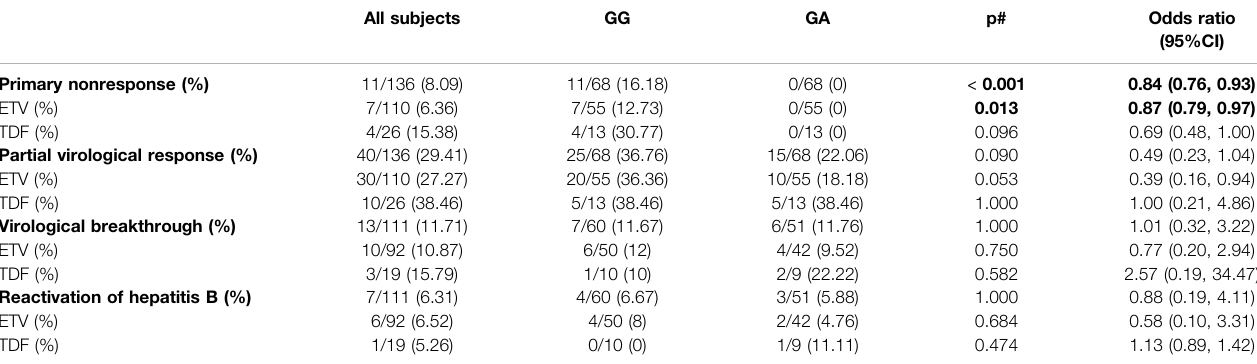
TABLE 2 | Virological outcome of patients using First-line NAs in propensity matching cohort All subjects GG GA